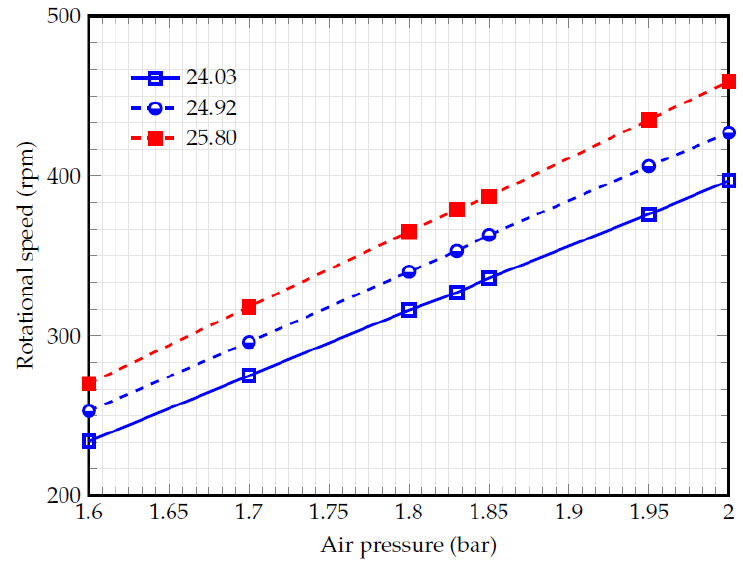
Figure 12. Rotational speed vs. inlet pressure by changing piston cylinder’s